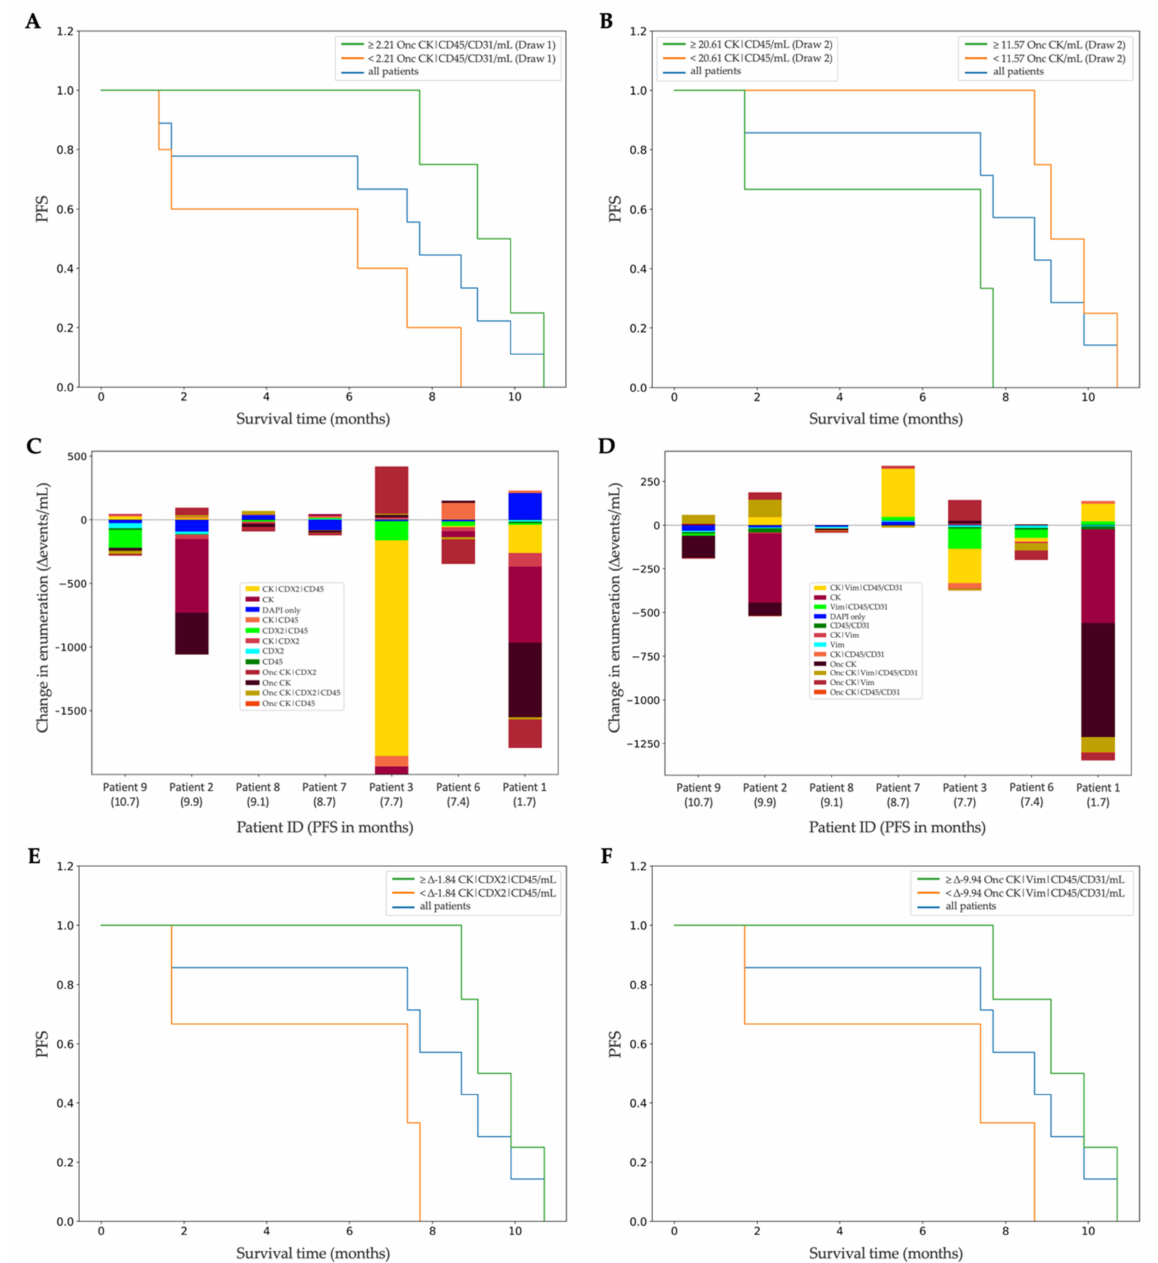
Figure 5. Survival analysis of rare events from the Landscape- and CDX2-targeted immunofluores- cence protocols. ( A ) Kaplan-Meier (KM) curve showing that patients with more than the median of 2.21 Onc CK|CD45/CD31/mL found in Draw 1 by the Landscape protocol had longer progression- free survival (PFS). ( B ) KM curve showing two rare events with survival implications found in Draw 2 by the CDX2-targeted protocol. Patients with more than the median of 20.61 CK|CD45 cells/mL or more than the median of 11.57 Onc CK/mL had shorter PFS. ( C ) Rare-event kinetics between Draw 1 and Draw 2 analyzed with the CDX2-targeted protocol, ordered from longest to shortest PFS. ( D ) Rare-event kinetics between Draw 1 and Draw 2 analyzed with the Landscape protocol, ordered from longest to shortest PF € ( E ) KM curve showing that patients with a change of ≥− 1.84 CK|CDX2|CD45 cells/mL from the CDX2-targeted protocol had longer PFS. ( F ) KM curve showing that patients with a change of ≥− 9.94 Onc CK|Vim|CD45/CD31/mL from the Landscape protocol had longer